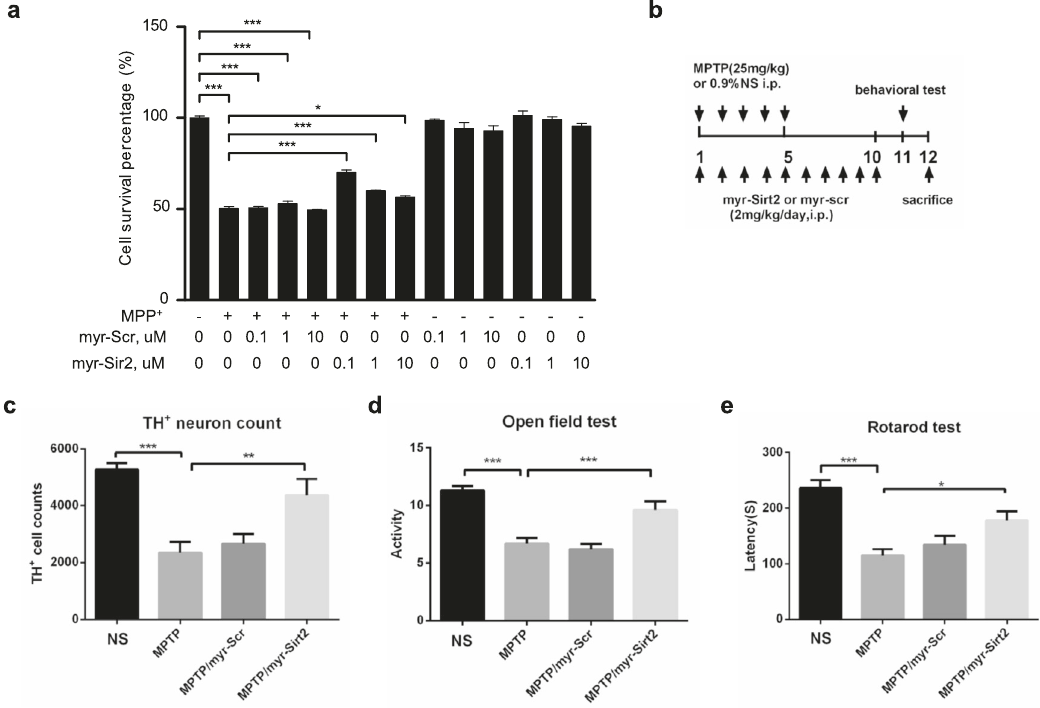
Fig. 7 Myr-SIRT2 328 – 339 interference peptide rescues neuronal death and motor behavior. a Primary culture neurons were pretreated with the SIRT2 328 – 339 or Scramble peptide conjugated with Myristic acid (Myr) and subsequently treated with 100 μ M MPP + for 48 h. The survival percentage of neurons was detected using an MTT assay. b , c Immunostaining for TH in the SNpc, d the open fi eld test, and e the rotarod